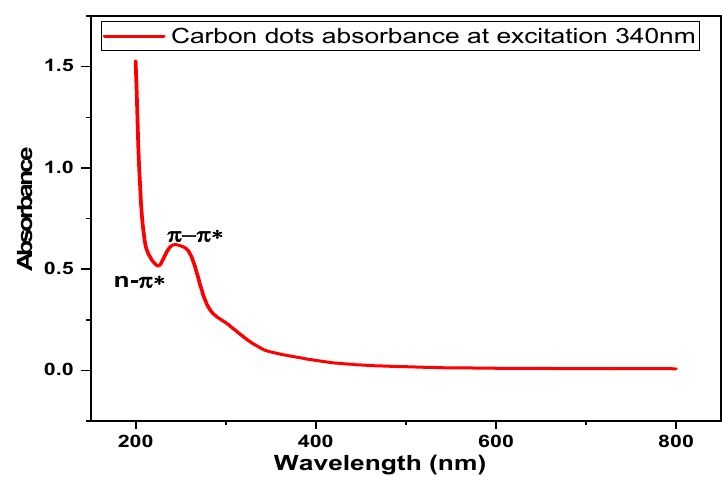
Figure 6. Optical properties of CDs by UV-visible absorption and emission spectra.